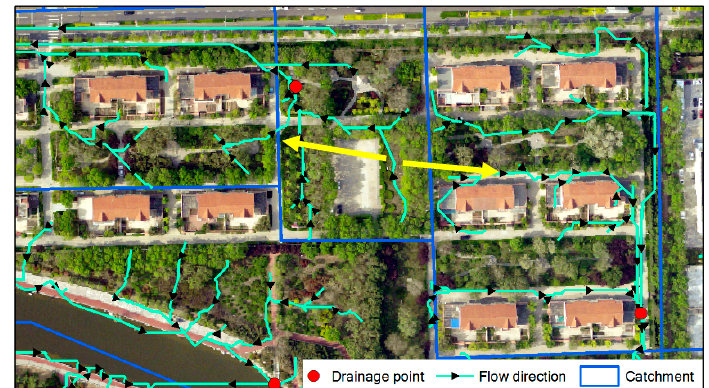
Figure 15. Land types with different flow directions partitioned as different catchment areas.